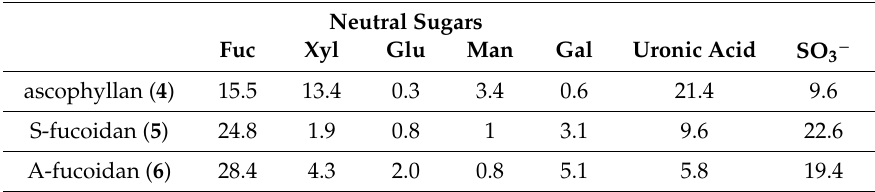
Figure 4. Structure of ascophyllan ( 4 ) and fucoidan unit. Table 2. Chemical composition of polysccharides (Fuc, Fucose; Xyl, Xylose; Glu, Glucose; Man, Mannose; Gal, Galactose) in ascophyllan, S- and A-fucoidan.